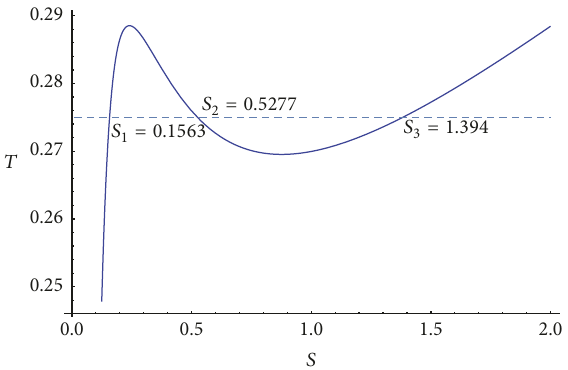
Figure 8: The figure shows 𝑇 versus 𝑆 for 𝛾 = −1 . Here 𝜆 = 2.4 , Λ = −3 , and 𝑄 = 0.6𝑄 𝑐